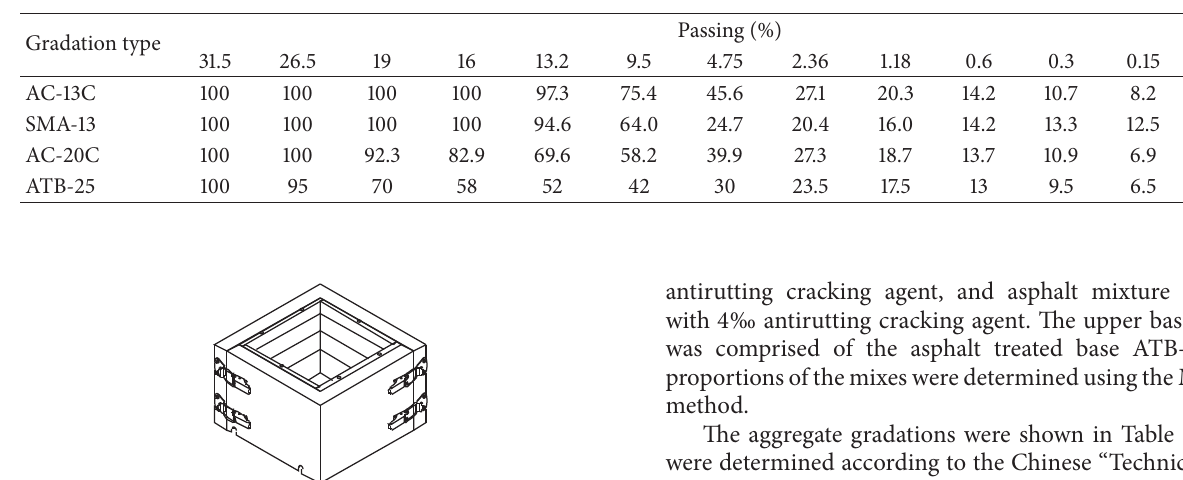
Table 1: Aggregate gradation of different mixtures.